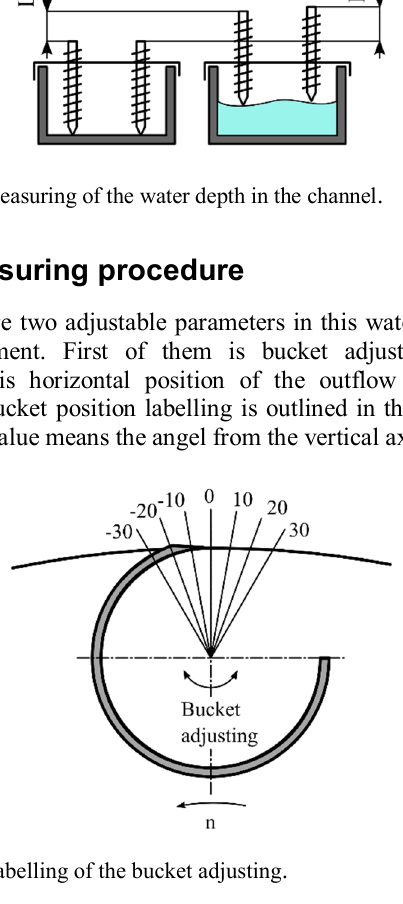
Fig. 6. Labelling of outflow channel edge position